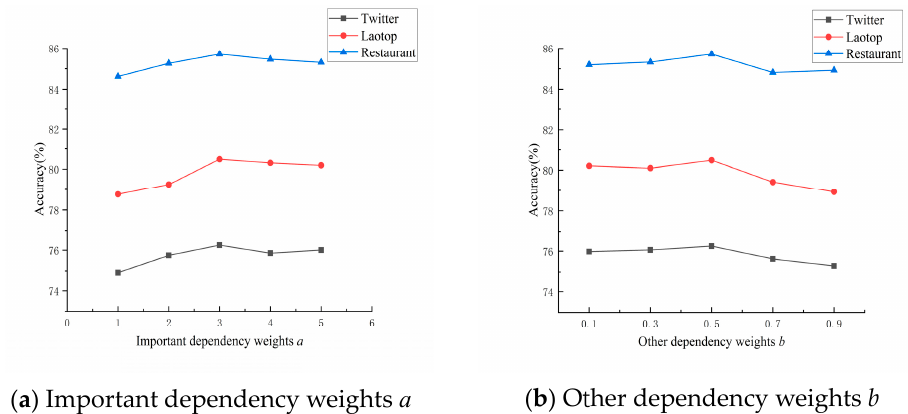
Figure 5. Performance of WGAT model on each dataset under different a and b .